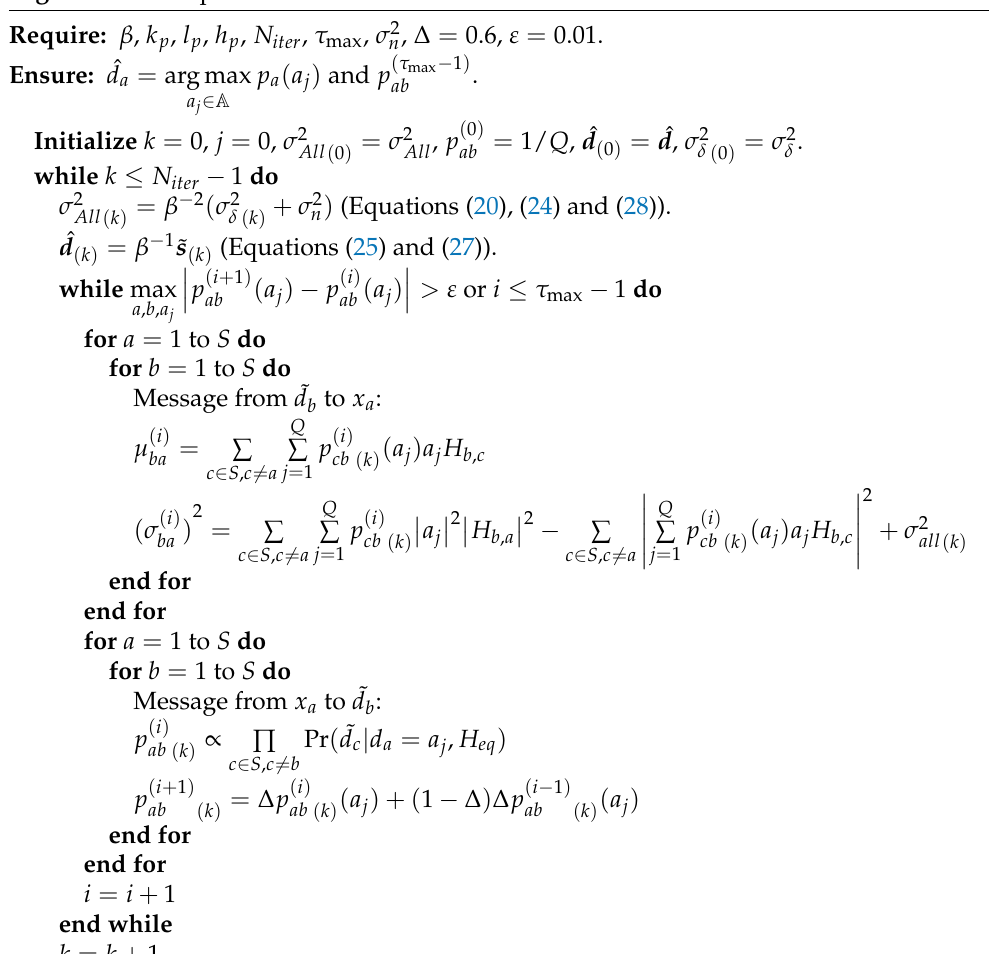
Algorithm 1 The procedure of the MP-AIC